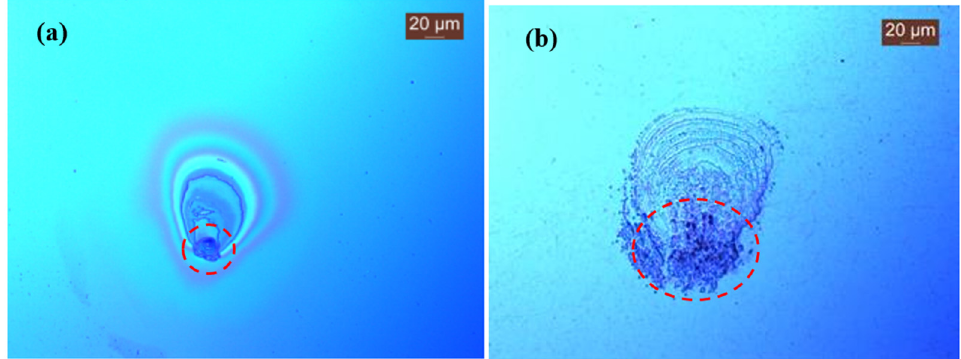
Figure 10. Typical damage morphologies of the dichroic beamsplitters at 1064 nm ( a ) and 532 nm ( b ) laser irradiation. The area inside the red dashed line marks the damage black spot.